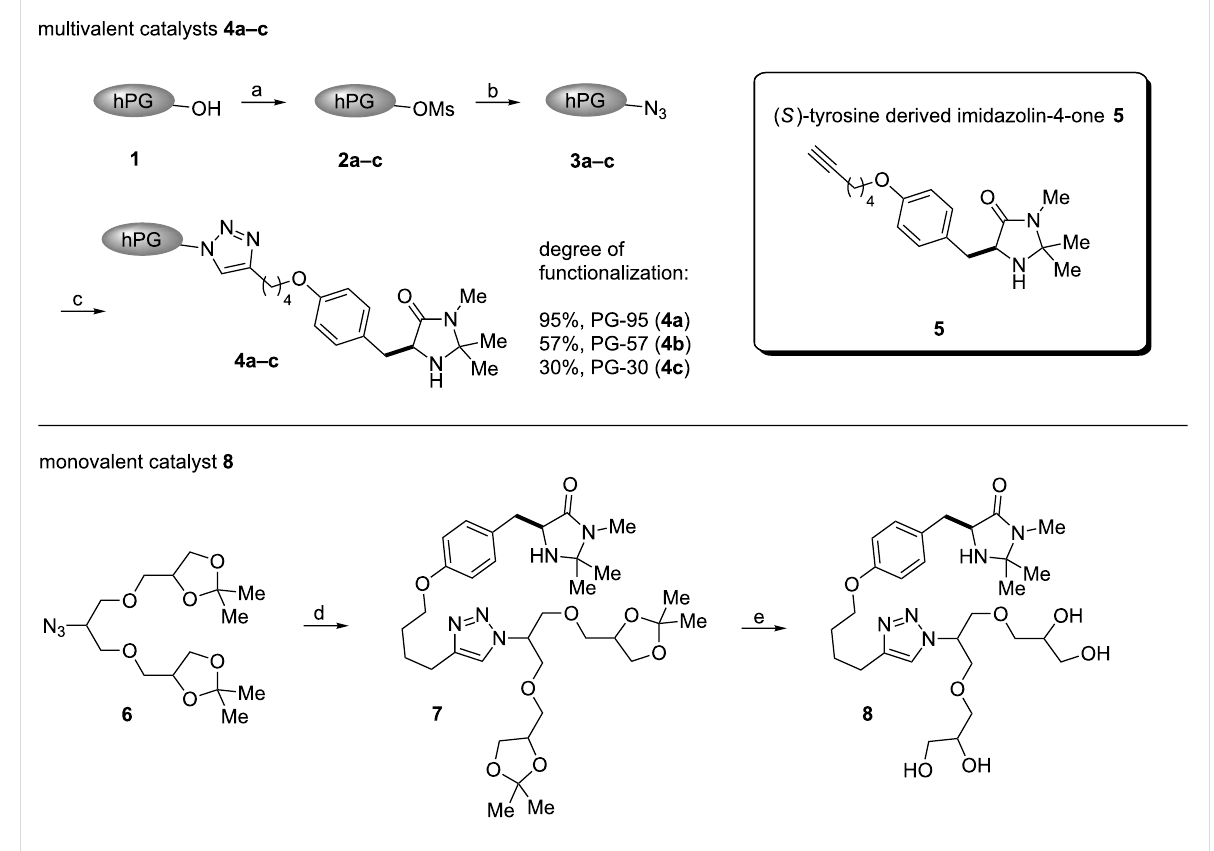
Scheme 1: Synthesis of hyperbranched polyglycerol-supported and G1 dendronized imidazolidin-4-ones 4a–c and 8 using a CuAAC reaction. Reac- tion conditions: (a) 1 (1.0 equiv), MsCl (1.2 equiv, with respect to degrees of functionalization), pyridine, 25 °C, 16 h, 76% 2a , 82% 2b and 87% 2c .